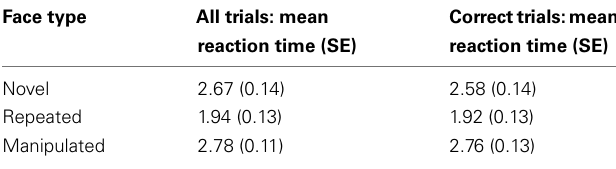
Table 2 | Mean reaction time in seconds (with